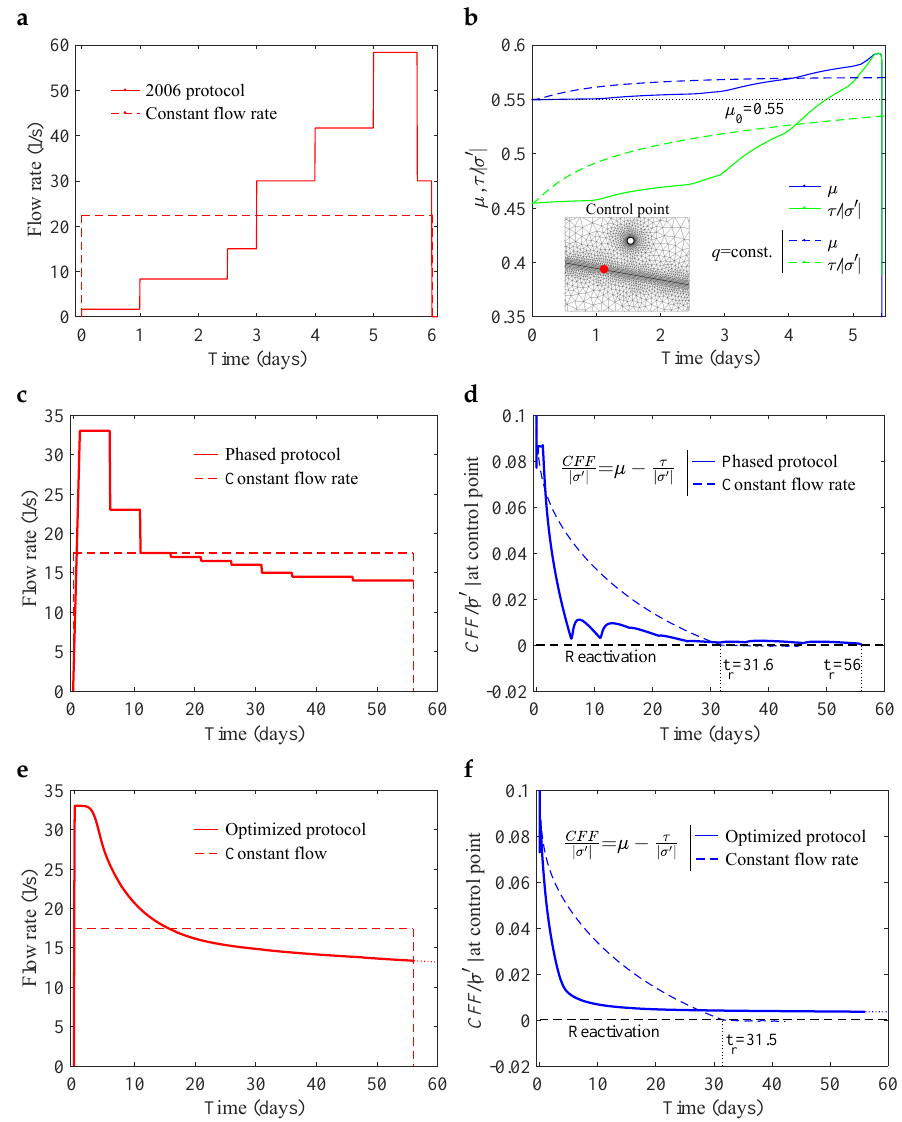
Figure 2. Optimization of the injection protocol for the Basel geothermal reservoir, based on fault reactivation predicted by the model. In panel ( a ), we show the conducted injection protocol in Basel-1 well in 2006 (solid line) and the one with a constant flow rate equal to 22.4 l/s (dashed line). In panel ( b ), we plot the change in friction variables with time on the fault control point, so when mobilized friction τ / | σ (cid:48) | (green line) equals the friction coefficient µ (blue line), the fault reactivates. This occurs for the injection protocol registered in 2006 but not for the injection at constant flow rate. In panel ( c ) we include a phased injection protocol designed to avoid fault reactivation, which consists of a series of 11 injections at a constant flow rate for 5 days. In panel ( d ), we show the change with time in the dimensionless Coulomb failure function, CFF / | σ (cid:48) | , on the fault control point. For the phased protocol, reactivation would occur at 56 days (continuous line), while for the injection at a constant flow rate, the reactivation occurs at 31.6 days (dashed line). In panel ( e ), we represent an optimized injection protocol that avoids fault reactivation. The dashed line shows the constant flow rate required to inject the same volume in the same duration. The change in the dimensionless Coulomb failure function, CFF / | σ (cid:48) | , with time for both injection protocols is depicted ( f ). The fault reactivates after 31.5 days of injection when water is injected at a constant flow rate, whereas the fault does not reactivate with the optimized